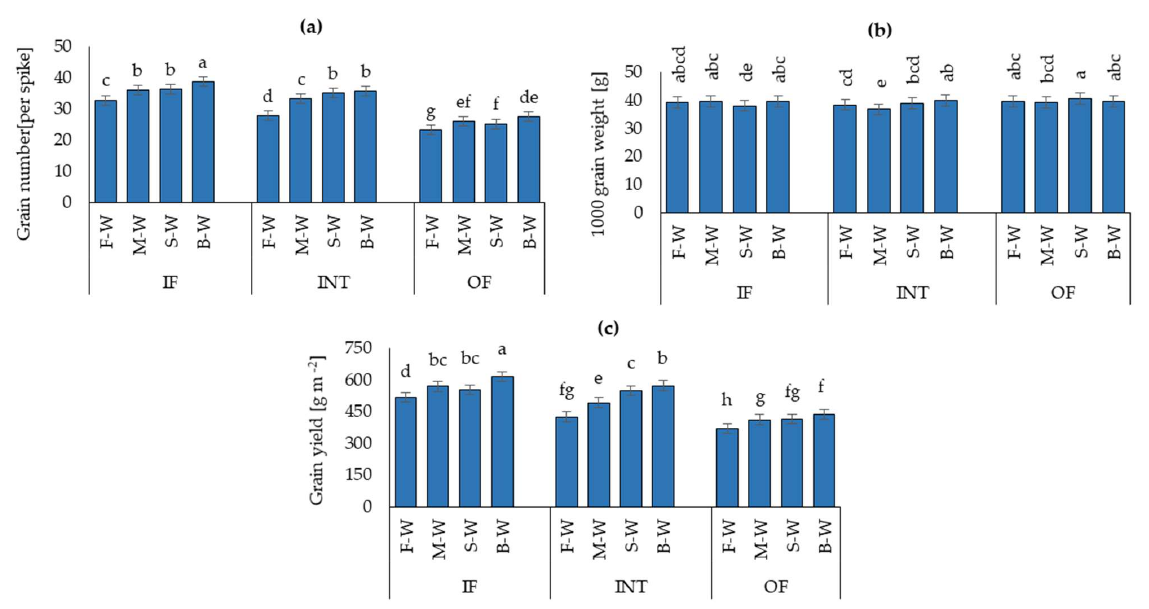
Figure 5. Interaction effect of three farm management practices (intensive, IF; organic, OF; and integrated, INT) and four crop rotation systems (fallow-wheat (F-W); maize-wheat (M-W); sesame-wheat (S-W), and mung bean-wheat (B-W) on ( a ) grain number per spike, ( b ) 1000-grain weight,